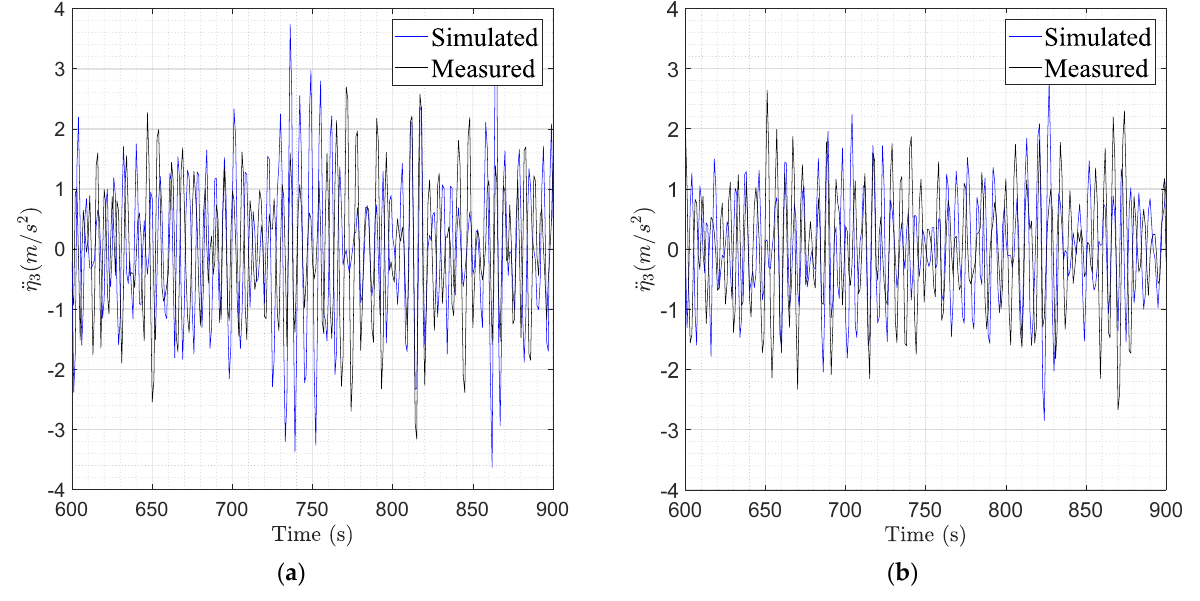
Figure 9. Pitch time series comparison: ( a ) 7 January 2020; ( b ) 8 January 2020.